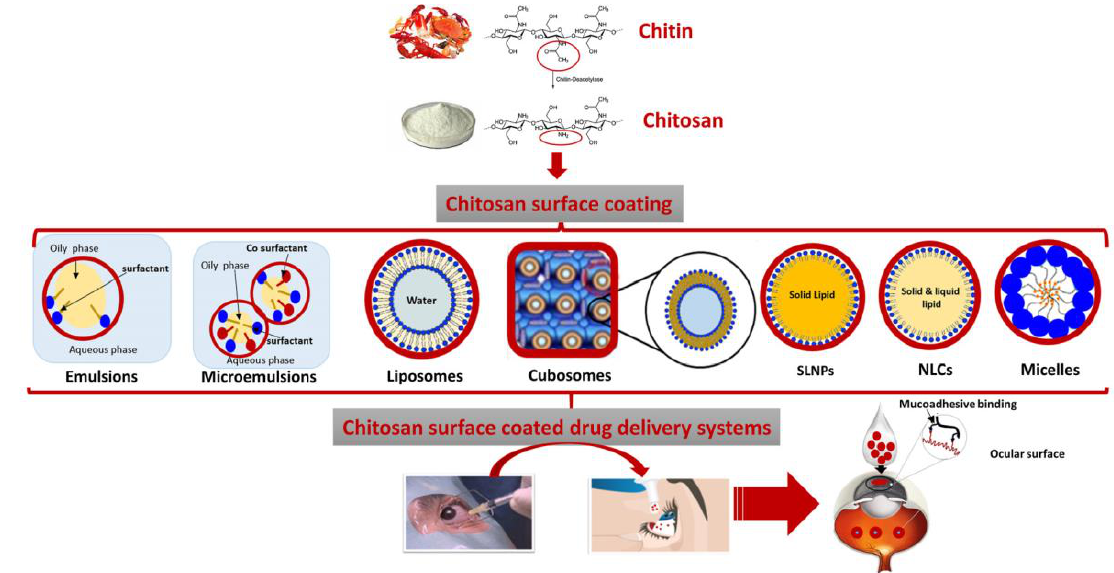
Figure 4. Use of chitosan surface coating on posterior segment ophthalmic delivery. Figure adapted from Ref. [64].